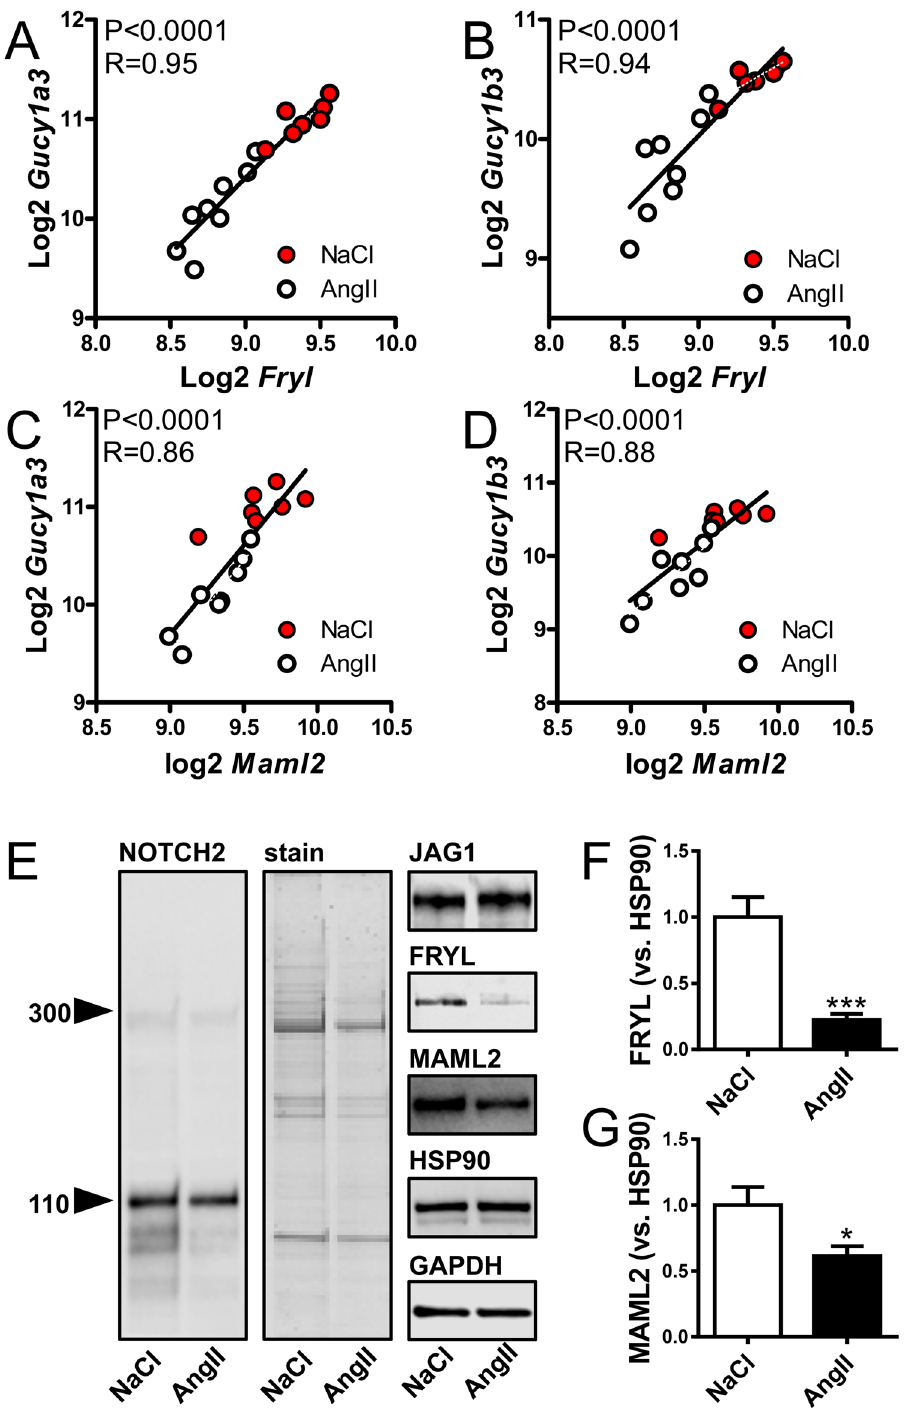
Figure 3. Repression of Gucy1a3 and Gucy1b3 correlates with changes in the Notch coactivators Fryl and Maml2 . Panels A through D show correlations between Fryl and Maml2 and the sGC subunits Gucy1a3 and Gucy1b3 at the mRNA level. Data is from the microarray experiment. P-values and Spearman Rho coefficients are given in the respective panels. Correlations were also observed when AngII-treated mice were considered individually ( Gucy1a3 : P AngII = 0.005, P vehicle = 0.06; Gucy1b3 : P AngII = 0.015, P vehicle = 0.24). Panel E shows western blots (n = 6/group) for aortic NOTCH2, JAG1, FRYL and MAML2 in vehicle and AngII-infused mice. Coomassie-stained proteins remaining on the gel after transfer was used as loading control for NOTCH2. HSP90 and GAPDH were used as loading controls for JAG1, FRYL and MAML2. Panels F and G show summarized western blot data for FRYL and MAML2, respectively (versus HSP90, * P <